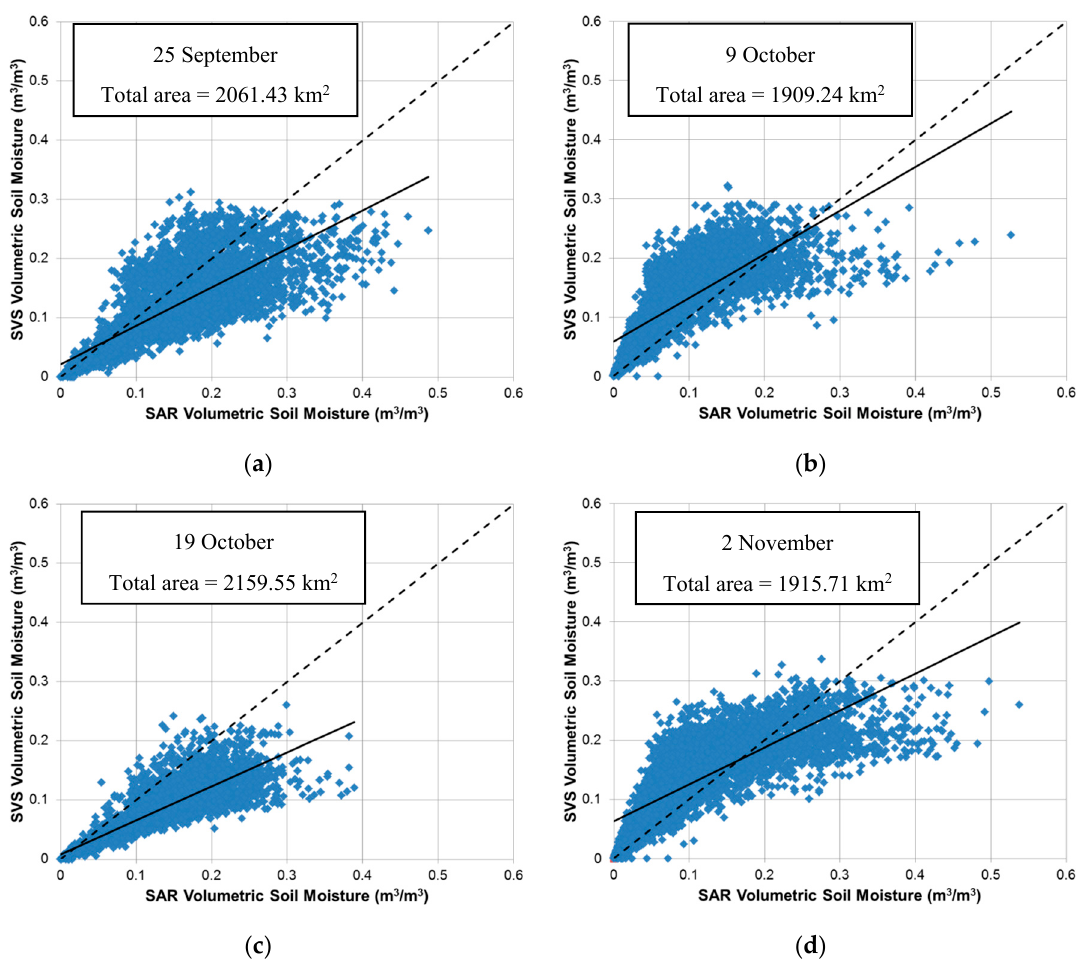
Figure 10. Scatterplots of the modeled (SVS) and estimated (SAR) soil moisture over sand polygons for ( a ) 25 September, ( b ) 9 October, ( c ) 19 October, and ( d ) 2 November. The dashed line is the 1:1 line and solid line is the regression line. Each dot represents the average soil moisture modeled (SVS) and estimated (SAR) of each soil polygon. The total area of the sand polygons in square kilometers is indicated in each plot.